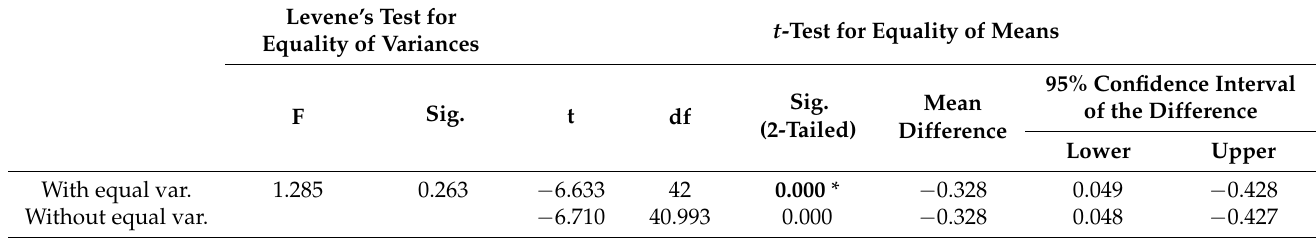
Table 4. The overall differences in students’ attitudes and tutors’ observations at distance/traditional learning modes.